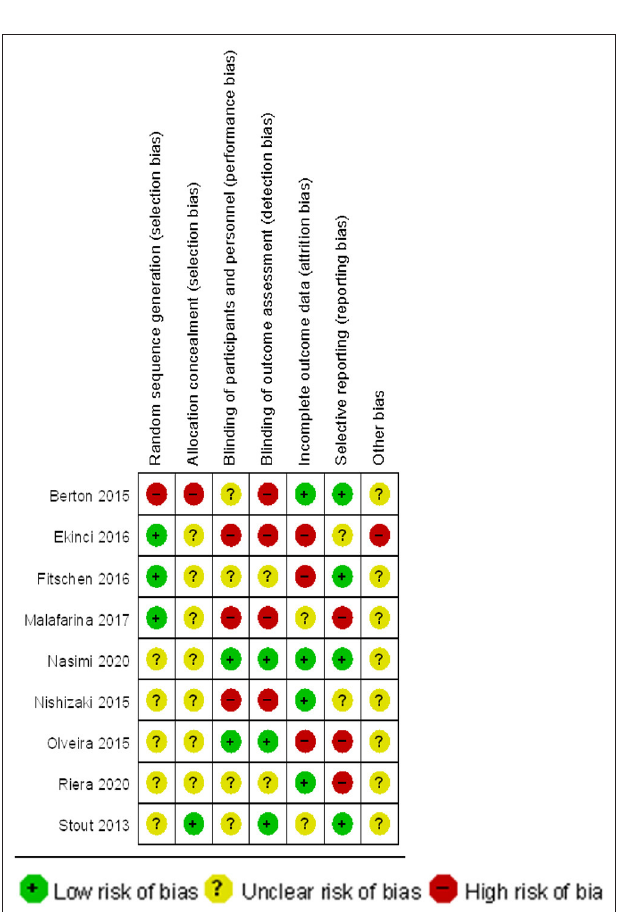
FIGURE 3 | Summary chart of risk of bias for inclusion on muscle strength studies.